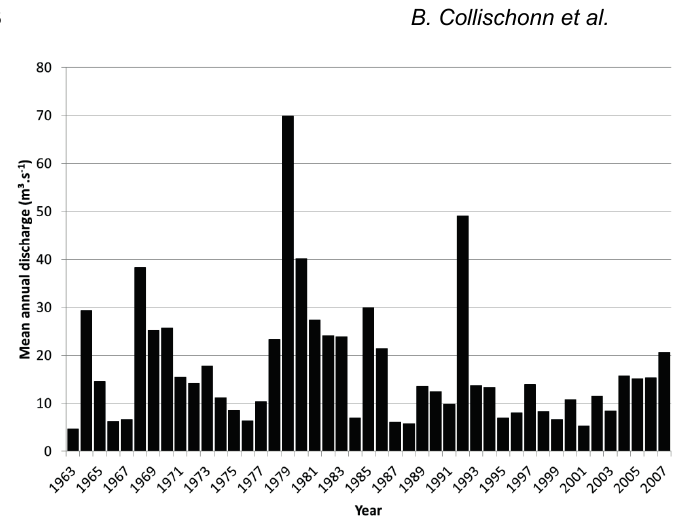
Fig. 2 Mean annual discharge of the Verde Grande River, from 1963 to 2007, showing a wet period preceding the early